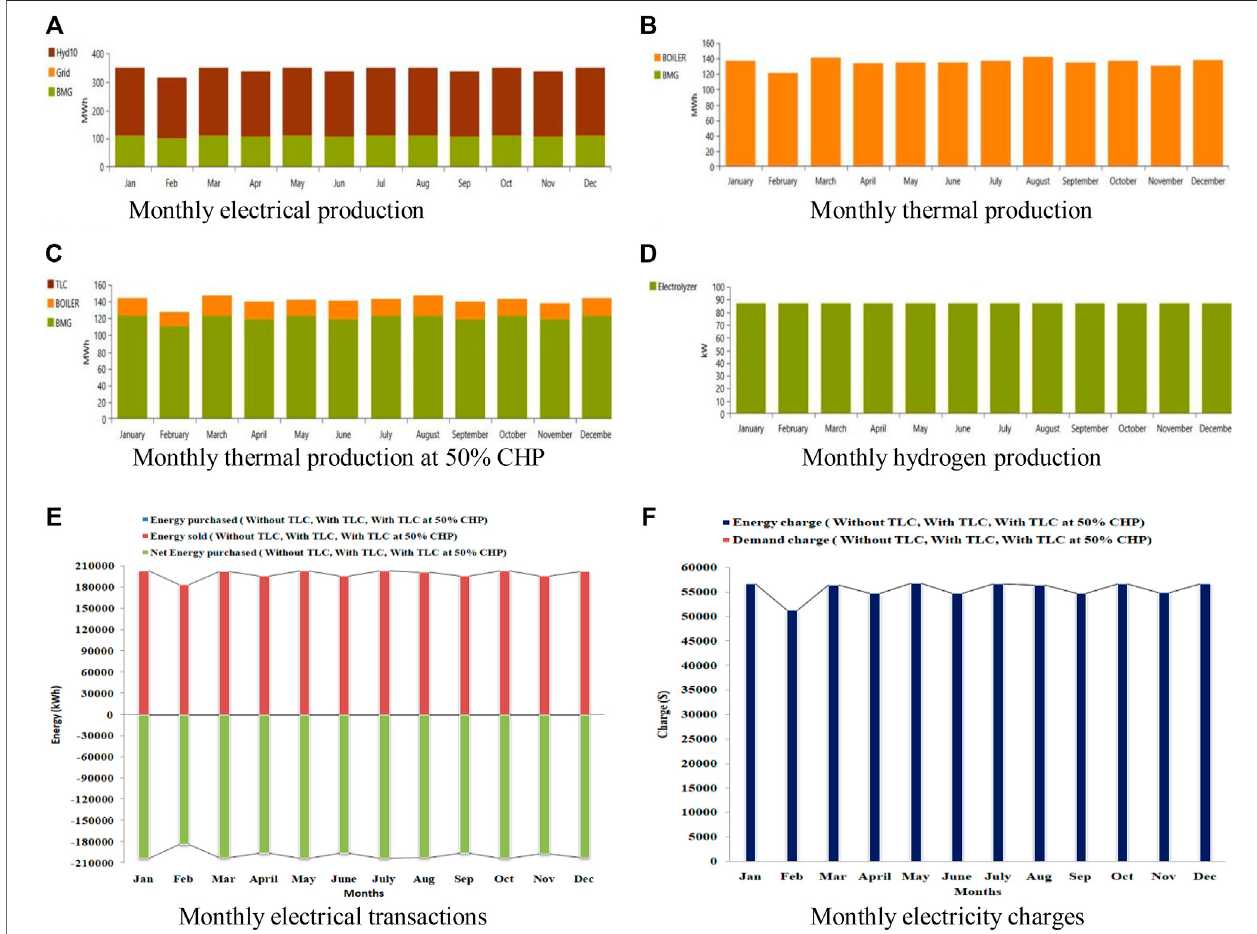
FIGURE 14 | Monthly energy productions, transactions, and charges. (A) Monthly electrical production. (B) Monthly thermal production. (C) Monthly thermal production at 50% CHP. (D) Monthly hydrogen production. (E) Monthly electrical transactions. (F) Monthly electricity charges.